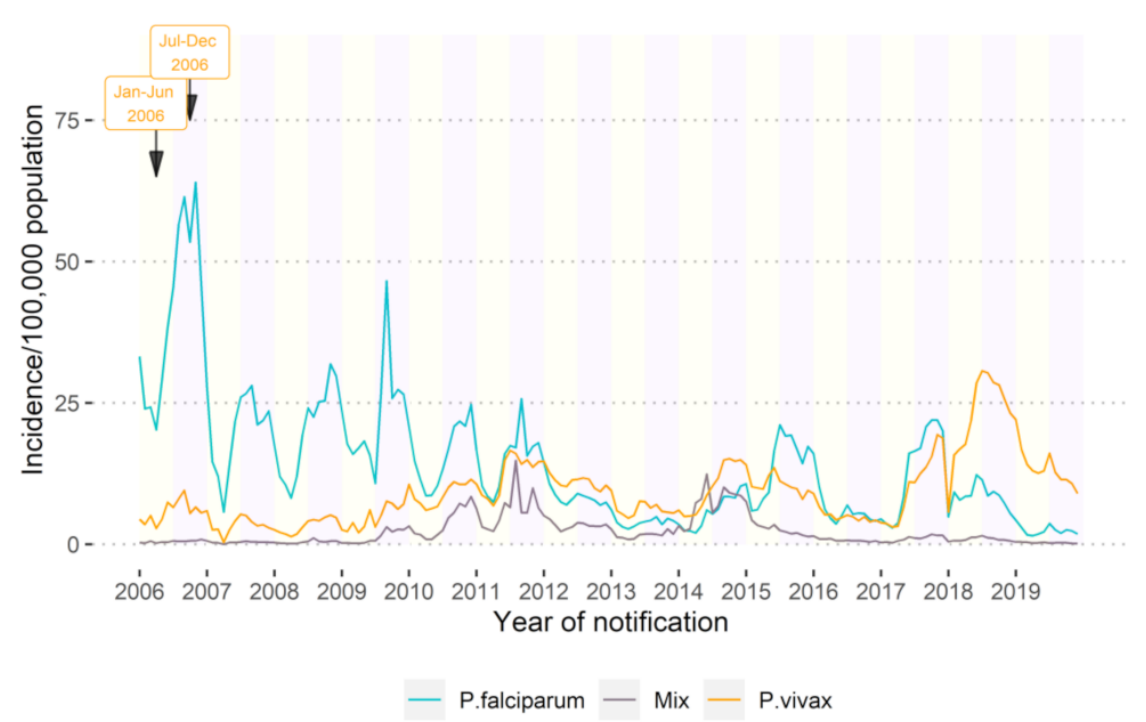
Figure 4. Malaria incidence (confirmed + unconfirmed) per 100,000 populations per month (2006–2019), in 2006–2019,